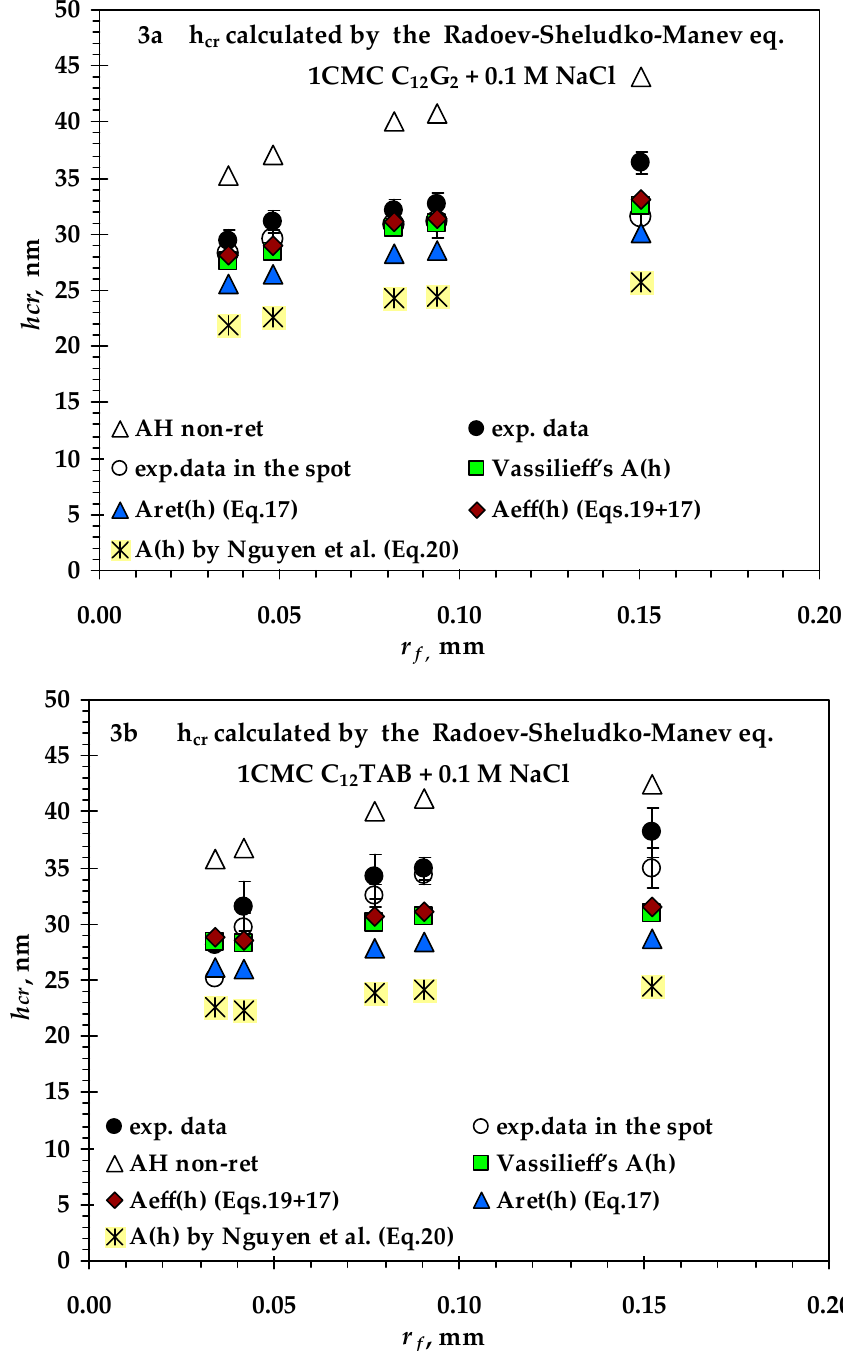
Figure 3. Measured and calculated critical thickness ( h cr ) by Radoev–Scheludko–Manev equation with 301